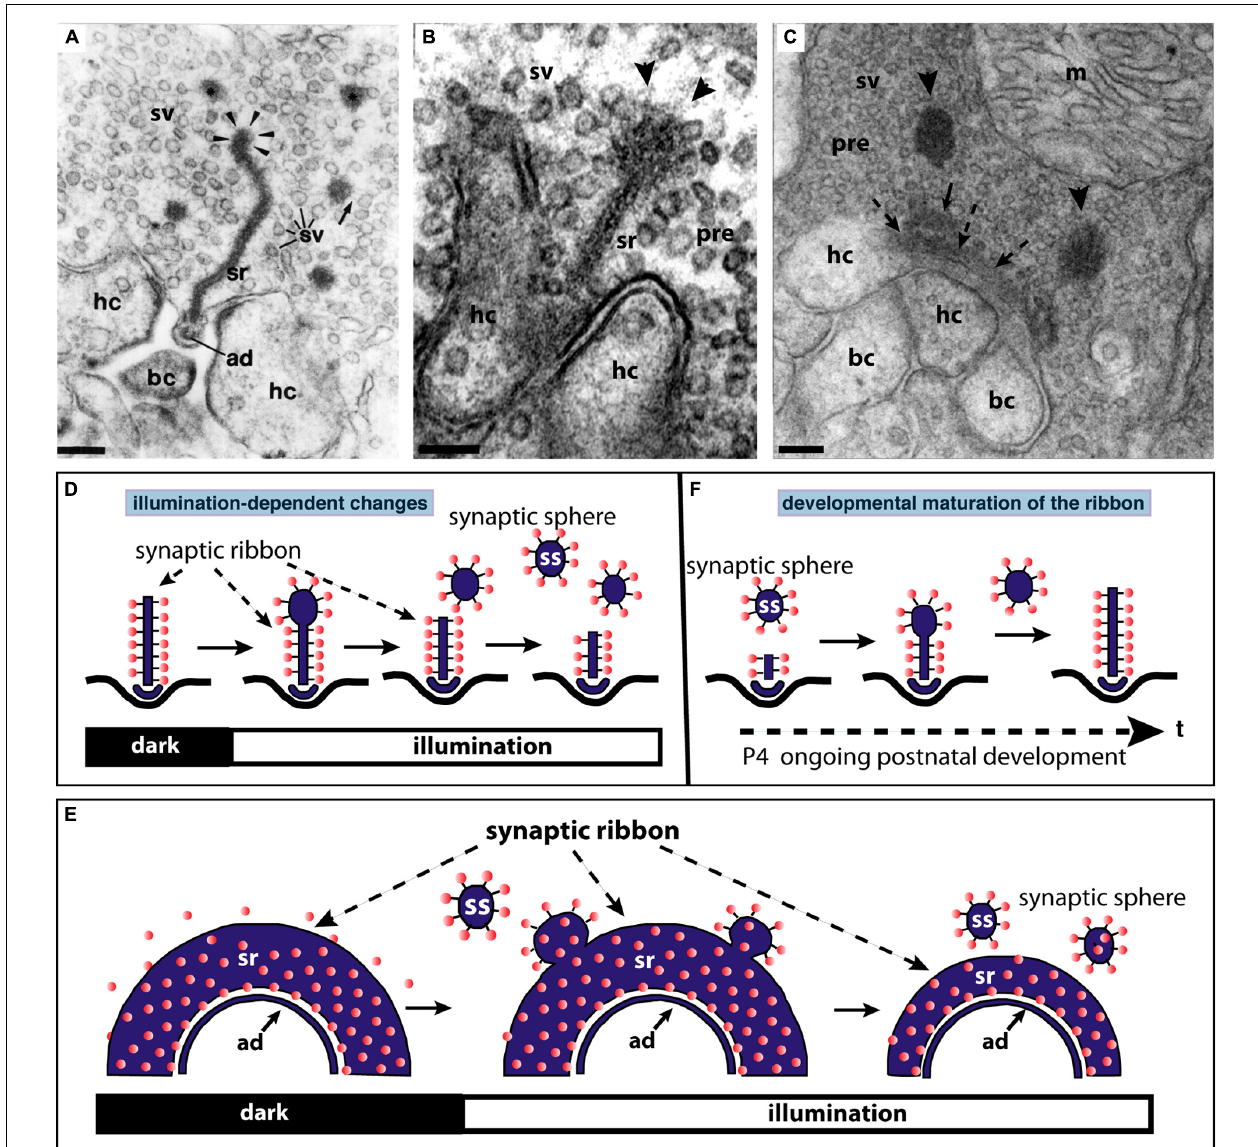
FIGURE 3 |The synaptic ribbon is a dynamic structure, both in the mature retina (A,B,D,E) as well as in the immature retina during early postnatal retinal development (C,F). Panels (A,B) show disassemblying synaptic ribbons in the mature retina. The mature, bar-shaped synaptic ribbon disassembles via spherical structures, the synaptic spheres (arrowheads in A,B ). Disassembly into synaptic spheres occurs at the cytosolic, non-plasma membrane-anchored end of the synaptic ribbon (arrowheads in A,B ). At this end, the synaptic ribbon appears enlarged before the spherical synaptic spheres detach from it (A,B) . The spherical synaptic ribbons are still associated with synaptic vesicles via thin connections. But they are no longer anchored to the presynaptic plasma membrane. Panel (A) is modified from Schmitz and Drenckhahn (1993) with permission from Springer-Verlag, Berlin, Heidelberg, Germany. (C) Assembly of the mature, bar-shaped synaptic ribbon during postnatal development. The arciform density (ad) is clearly visible at the active zone (dashed arrowheads in C ). In the synapse shown in (C) , the assembly of the synaptic ribbon just started. A small piece of the ribbon is already assembled (small black arrow in C ) and anchored at the arciform density. Most of the ribbon is still present as